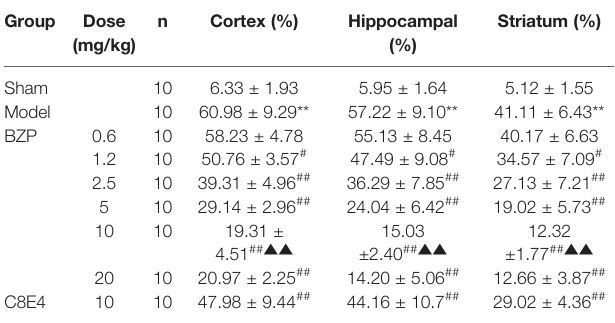
TABLE 2 | Effect of BZP on density and distribution of necrosis in MCAO rats.